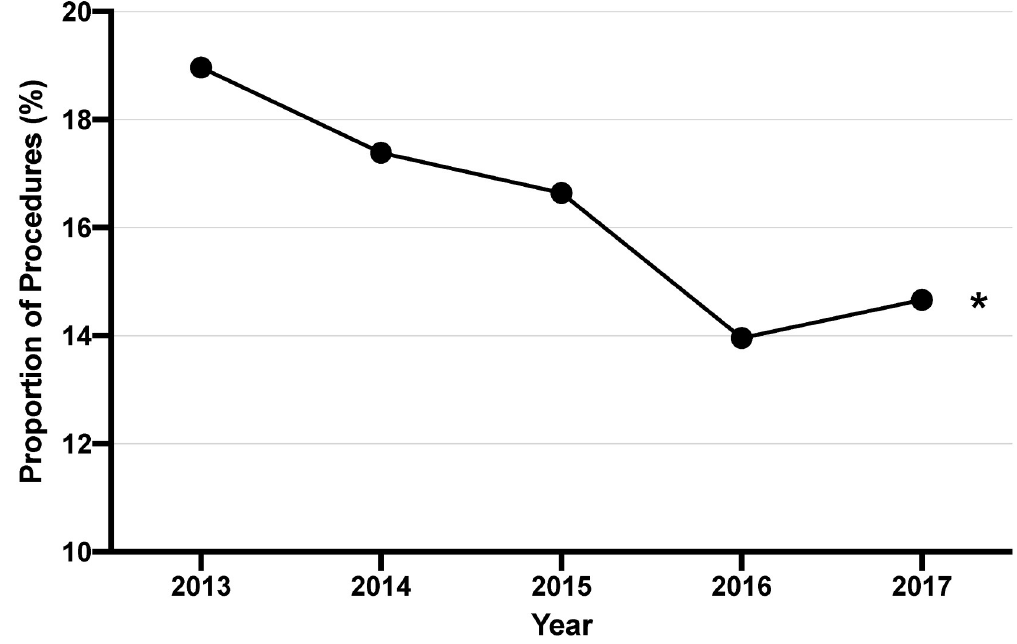
Fig 1. The proportion of extended procedures across all hospitals each year. � Significance at P <